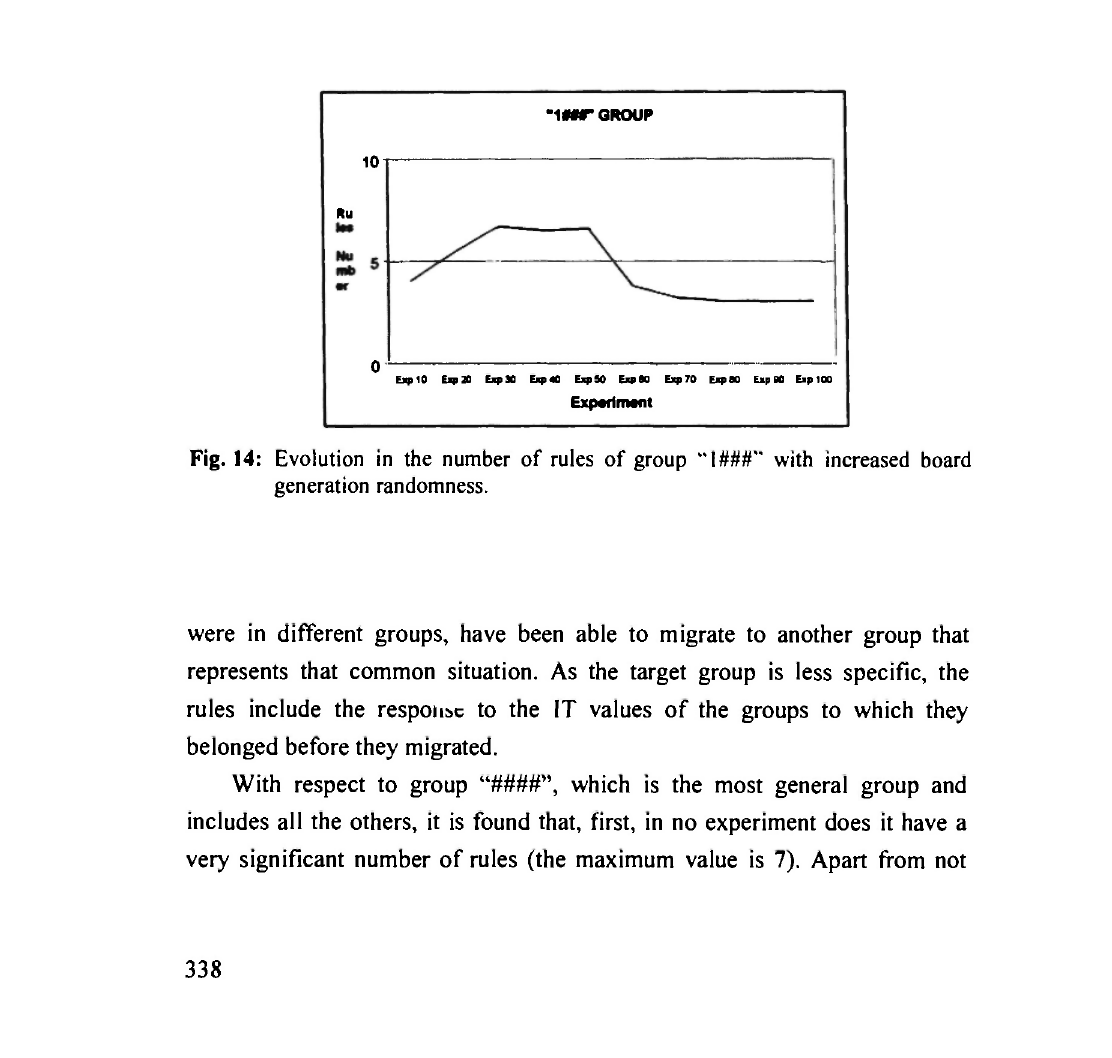
Fig. 13: Evolution in the number of rules of group "\##V with increased board generation randomness.